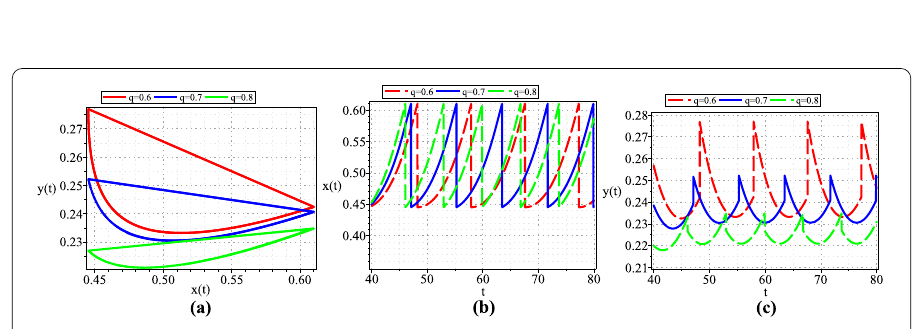
Figure 8 Numerical simulations in the case q ∗ < q < δ . ( a ) Phase portrait of x ( t ) and y ( t ). ( b ) Time series of x ( t ). ( c ) Time series of y ( t